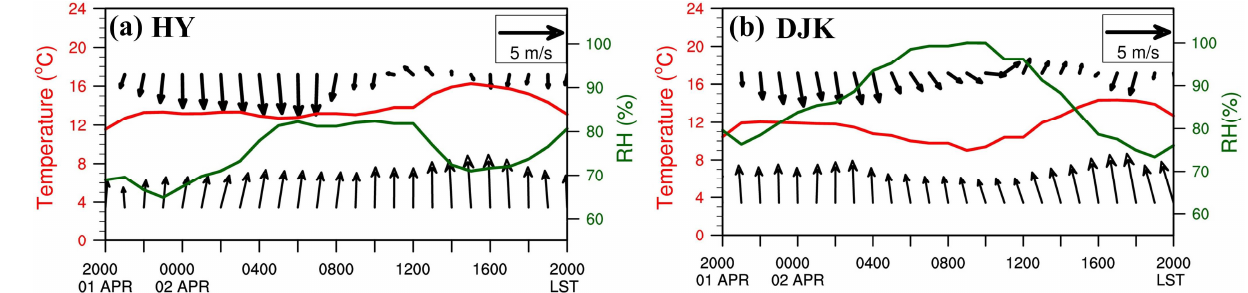
Figure 7. Simulated 2-m temperature (red line), 2-m RH (green line), and 10-m wind (lower vector) of Exp-LB0 at the two stations HY ( a ) and DJK ( b ). Upper vectors were 10-m winds in the result of Exp-Ctrl minus Exp-LB0. See the definition of wind direction in Figure 4.